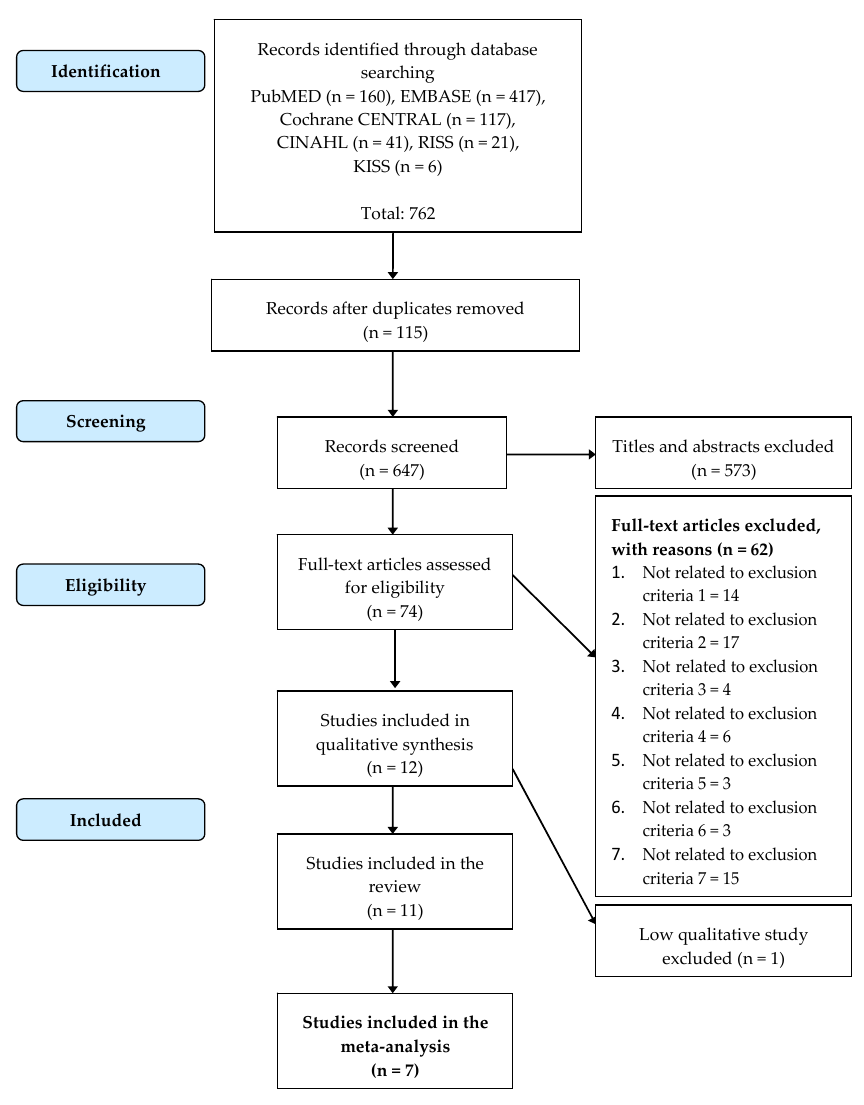
Figure 1. PRISMA flow chart of study selection.